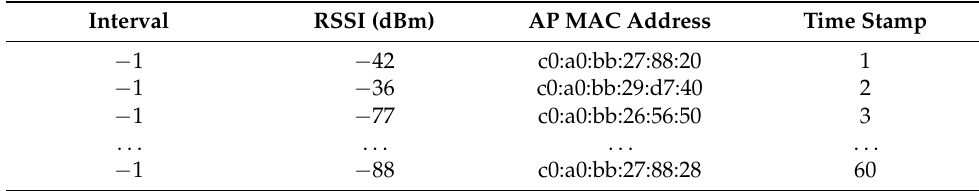
Table 2. Structure of the data